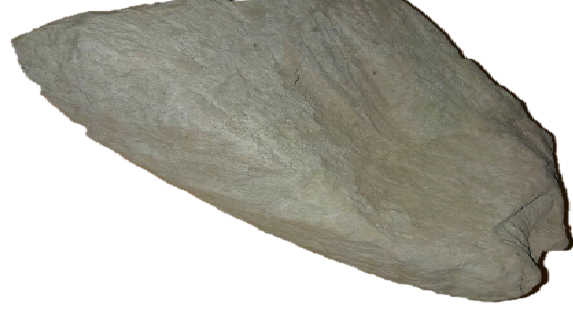
Figure 1: Natural (crude) trepel from Bitola region.